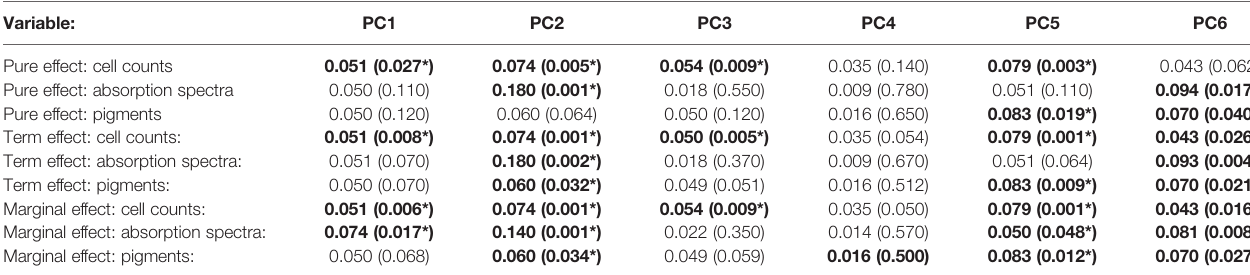
TABLE 2 | Pure, term and marginal signi fi cance testing for decomposed explanatory variables. Variable: